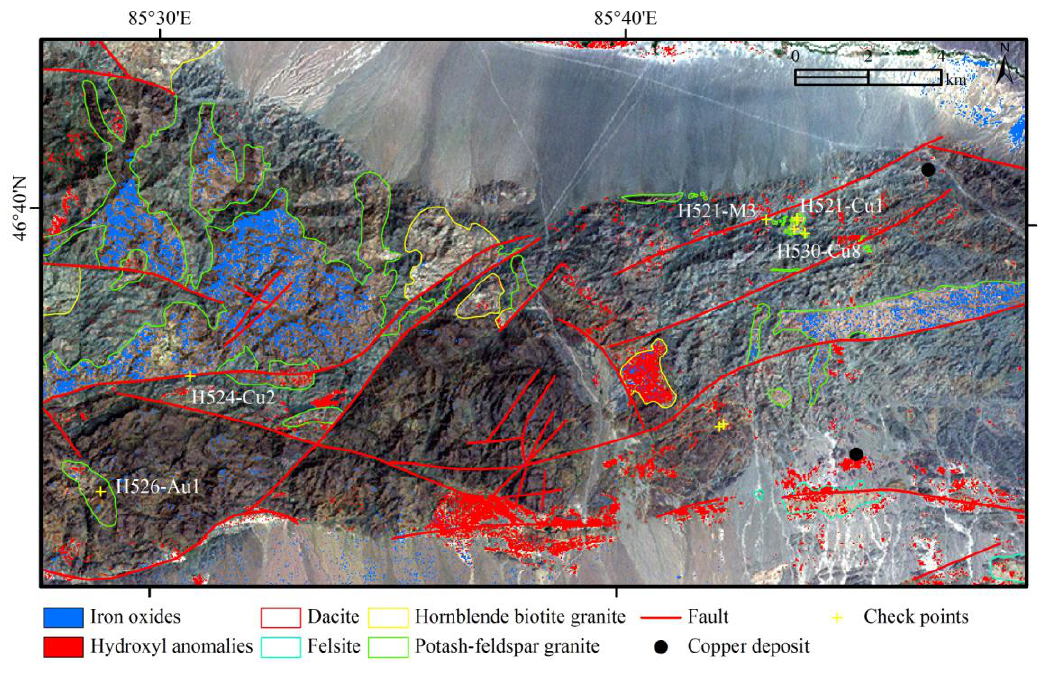
Figure 6. Color composites (ETM+ bands 3 (R), 2 (G), 1 (B)) overlaid with the remote-sensing anomalies using the Crosta technique (the labeled sites correspond to those highlighted in Table